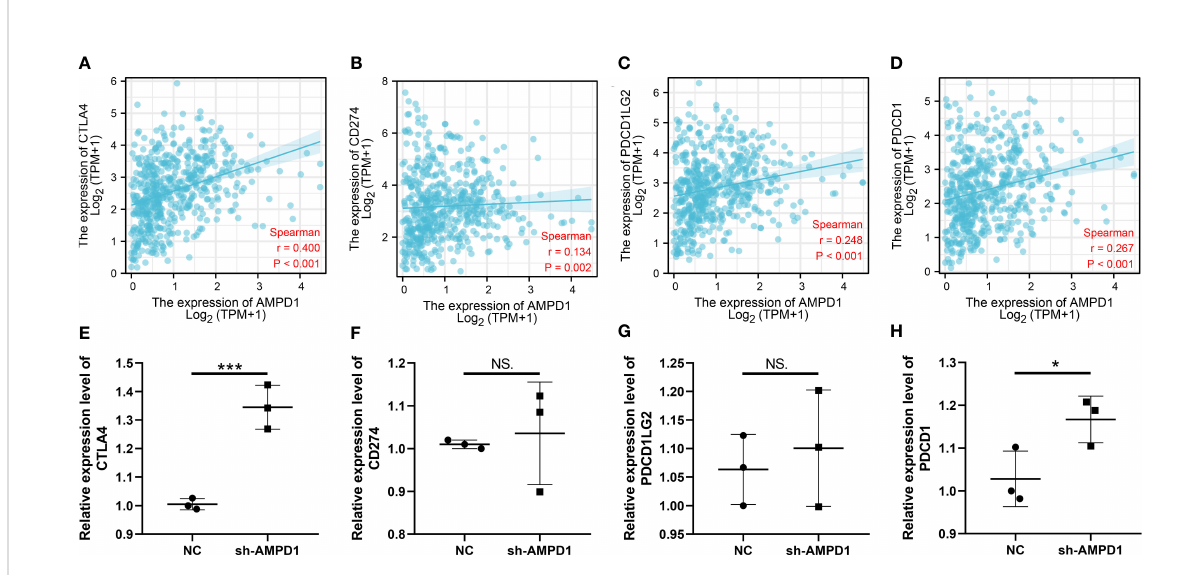
FIGURE 10 Correlation of AMPD1 and key immune checkpoints. (A-D) Correlation between AMPD1 and key immune checkpoints; (E-H) RNA level of key immune checkpoint in AMPD1 knockdown and control cells, NS P > 0.05, *P < 0.05, ***P <